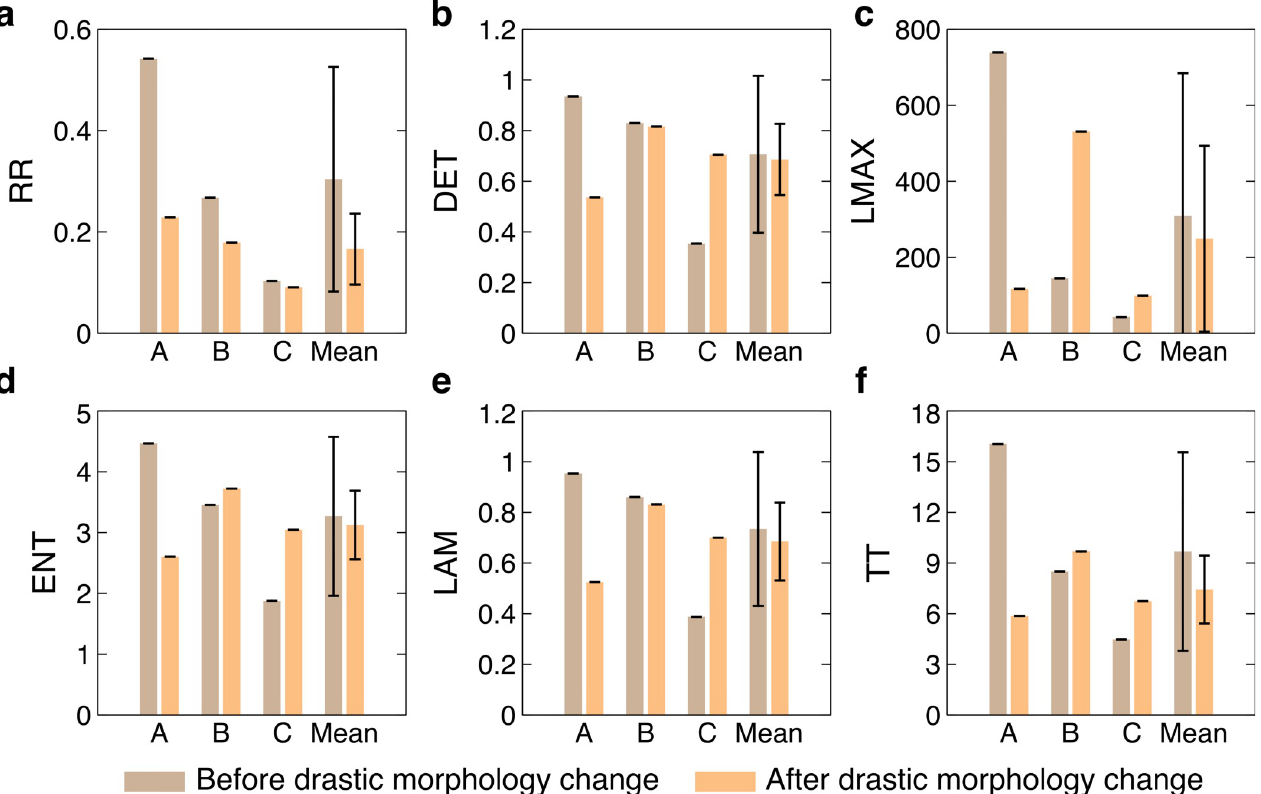
Fig 4. Recurrence quantification analysis. The recurrence rate ( RR ), determinism ( DET ), longest diagonal line ( LMAX ), entropy ( ENT ), laminarity ( LAM ) and trapping time ( TT ) for polyp A, polyp B and polyp C are shown in (a), (b), (c), (d), (e), (f), respectively. The means with error bars calculated by the standard deviation of corresponding quantities are also displayed. Corresponding quantities are shown in brown for the situation before the drastic morphology change and in orange for the situation after the drastic morphology change.